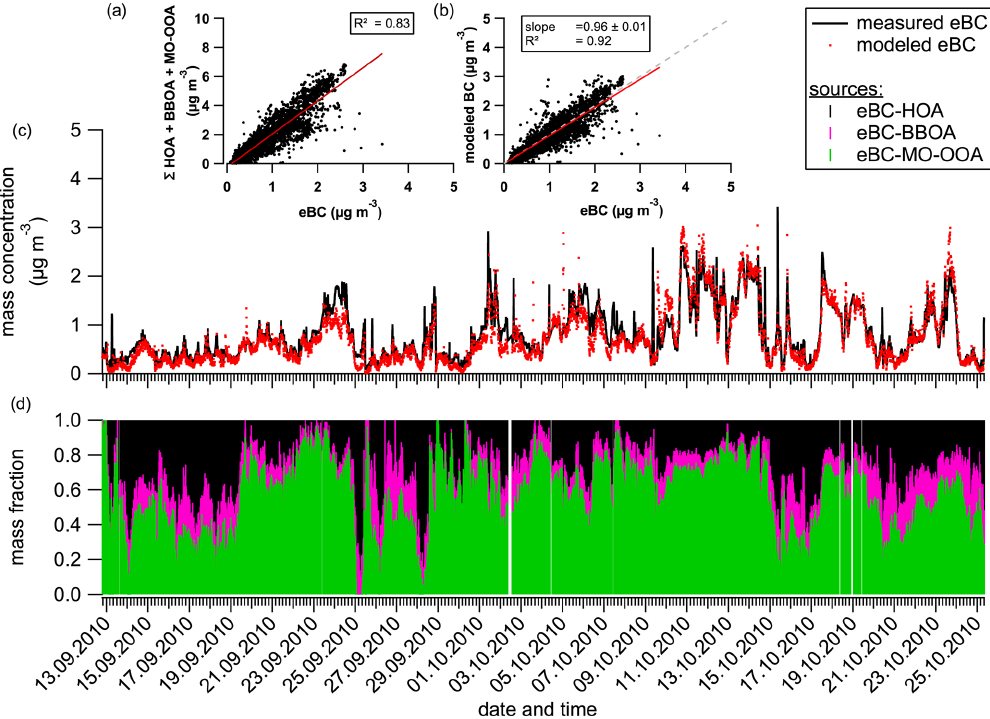
Figure 7. Contribution of the different organic factors to the eBC mass concentration. The scatter plots present the correlation between the sum of the OA factors and the measured eBC (a) and the estimated eBC concentration compared to the measured one (b) . Time series show comparisons between measured and modeled eBC (c) and contributions of each source to the modeled eBC concentration (d) . The correlation curves (red lines) were calculated using the least orthogonal distance fit